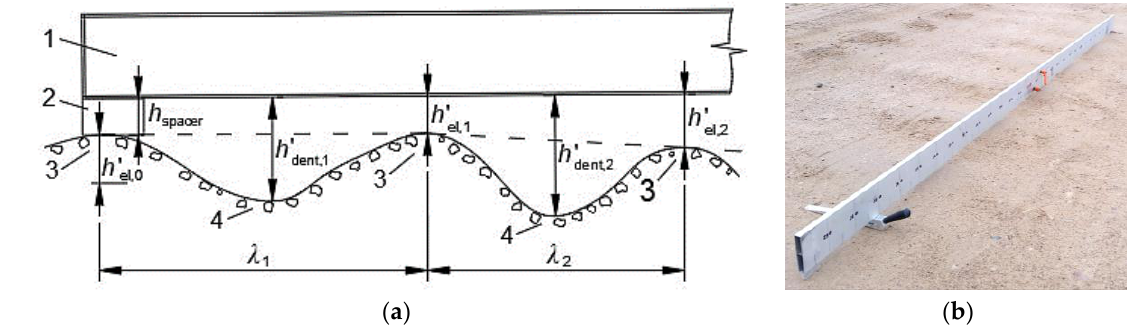
Figure 2. The measurement of gravel road roughness applying a straightedge: ( a ) schematic view, 1 — straightedge of 3 m in length; 2 — added spacer; 3 — pavement elevation; 4 — pavement dent; ( b ) measurement of gravel pavement.